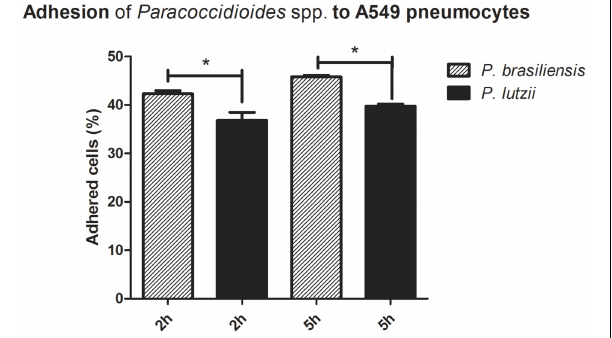
FIGURE 1 | Adhesion profile to A549 pneumocytes. Adhesion profiles of Paracoccidioides brasiliensis and Paracoccidioides lutzii to A549 pneumocytes after 2 and 5h of infection. * Indicates a statistically significant difference between the adhesion rates of each species, p < 0 . 05 .